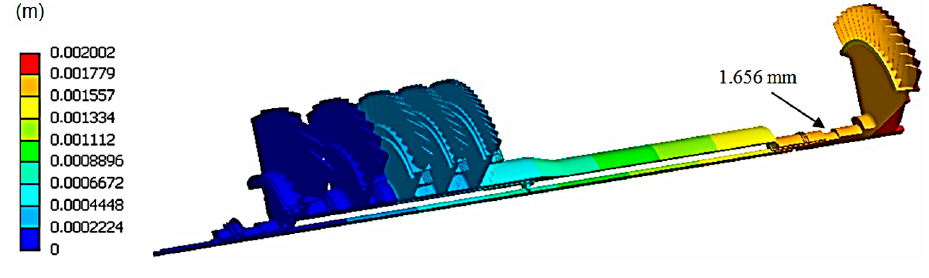
Figure 13. Thermal expansion along the rotating assembly.